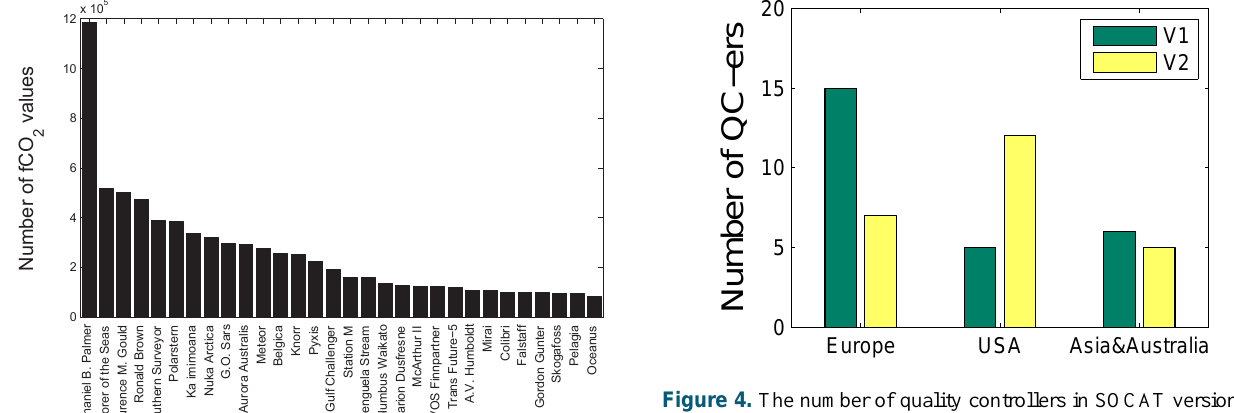
Figure 4. The number of quality controllers in SOCAT versions 1 and 2 based in Europe, the USA, Asia and Australia, respectively. control e ff ort in